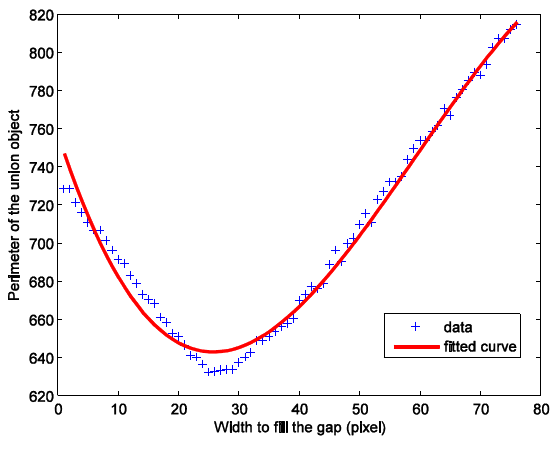
Figure 8. The perimeter of the connected river segment changes as the gap been filled with growing width centerline. The data in this Figure is related to Figure